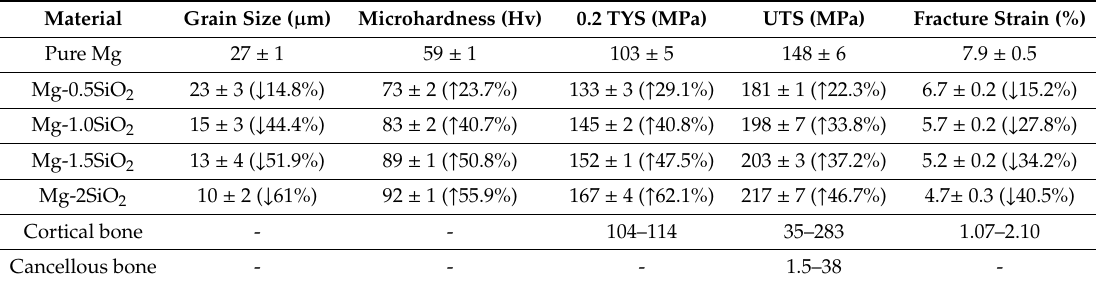
Table 2. Results of grain size measurements and tensile properties of pure Mg and Mg-SiO 2 syntactic